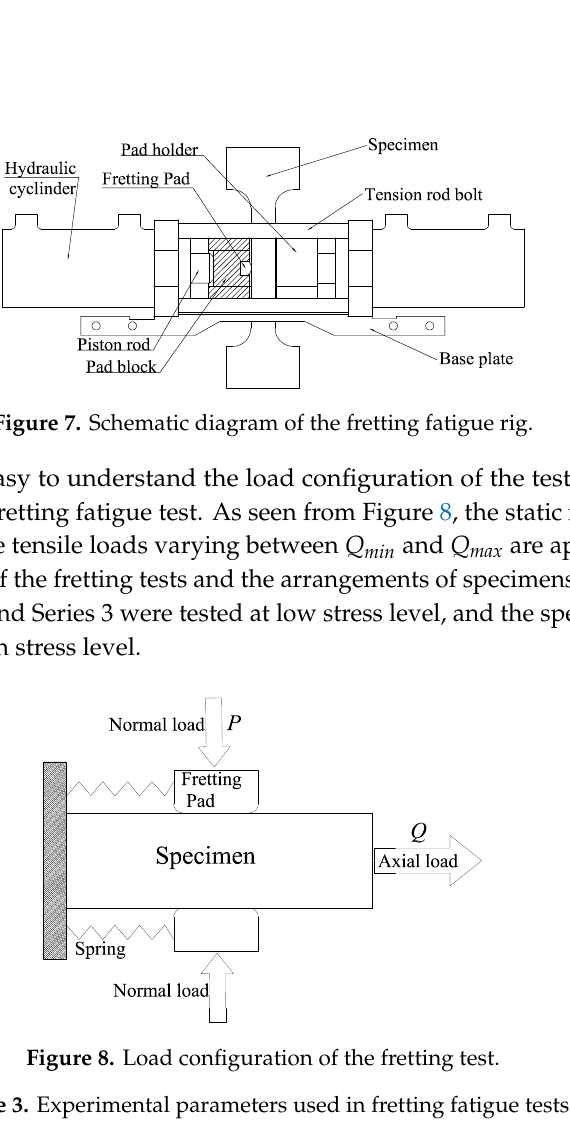
Figure 7. Schematic diagram of the fretting fatigue rig.